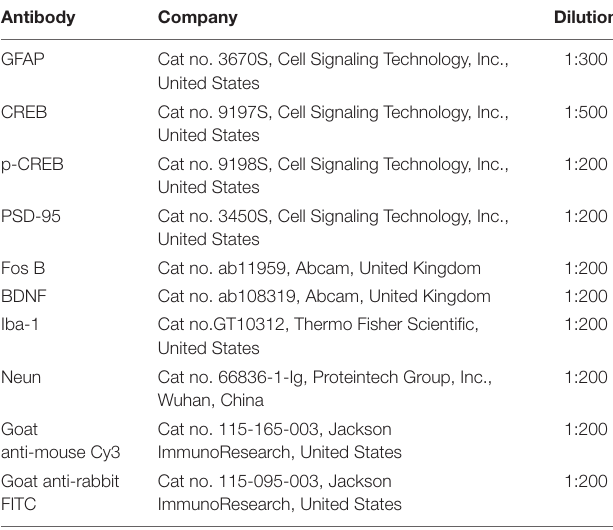
TABLE 2 | The primary antibodies for Immunofluorescence.